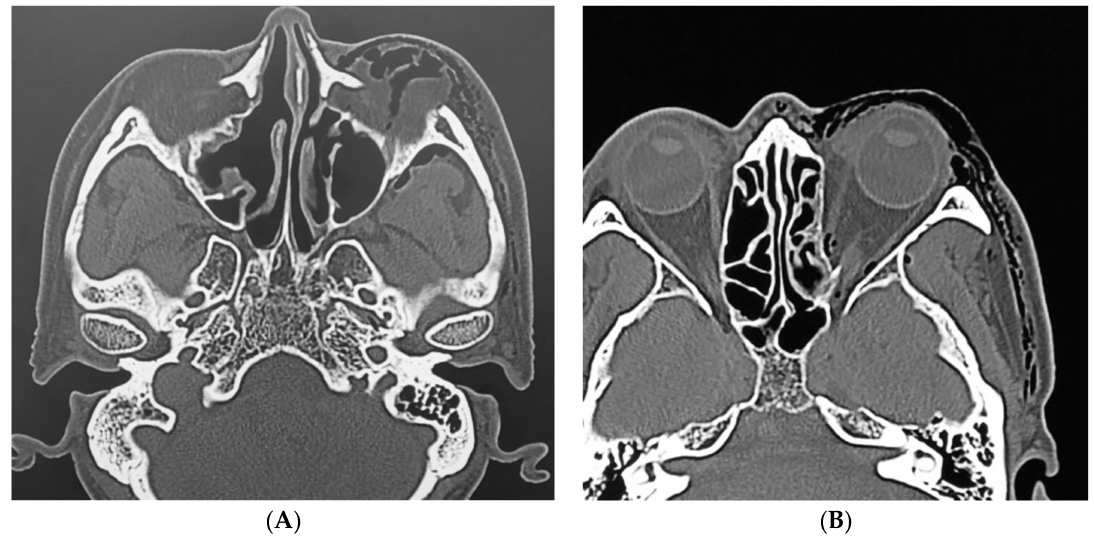
Figure 1. ( A ) Plain head computed tomography scan. A subcutaneous hematoma around the left orbit and temporal muscle is shown. The subcutaneous emphysema is visible in the orbit, which is continuous with the ethmoid sinus. ( B ) The left medial orbital wall is